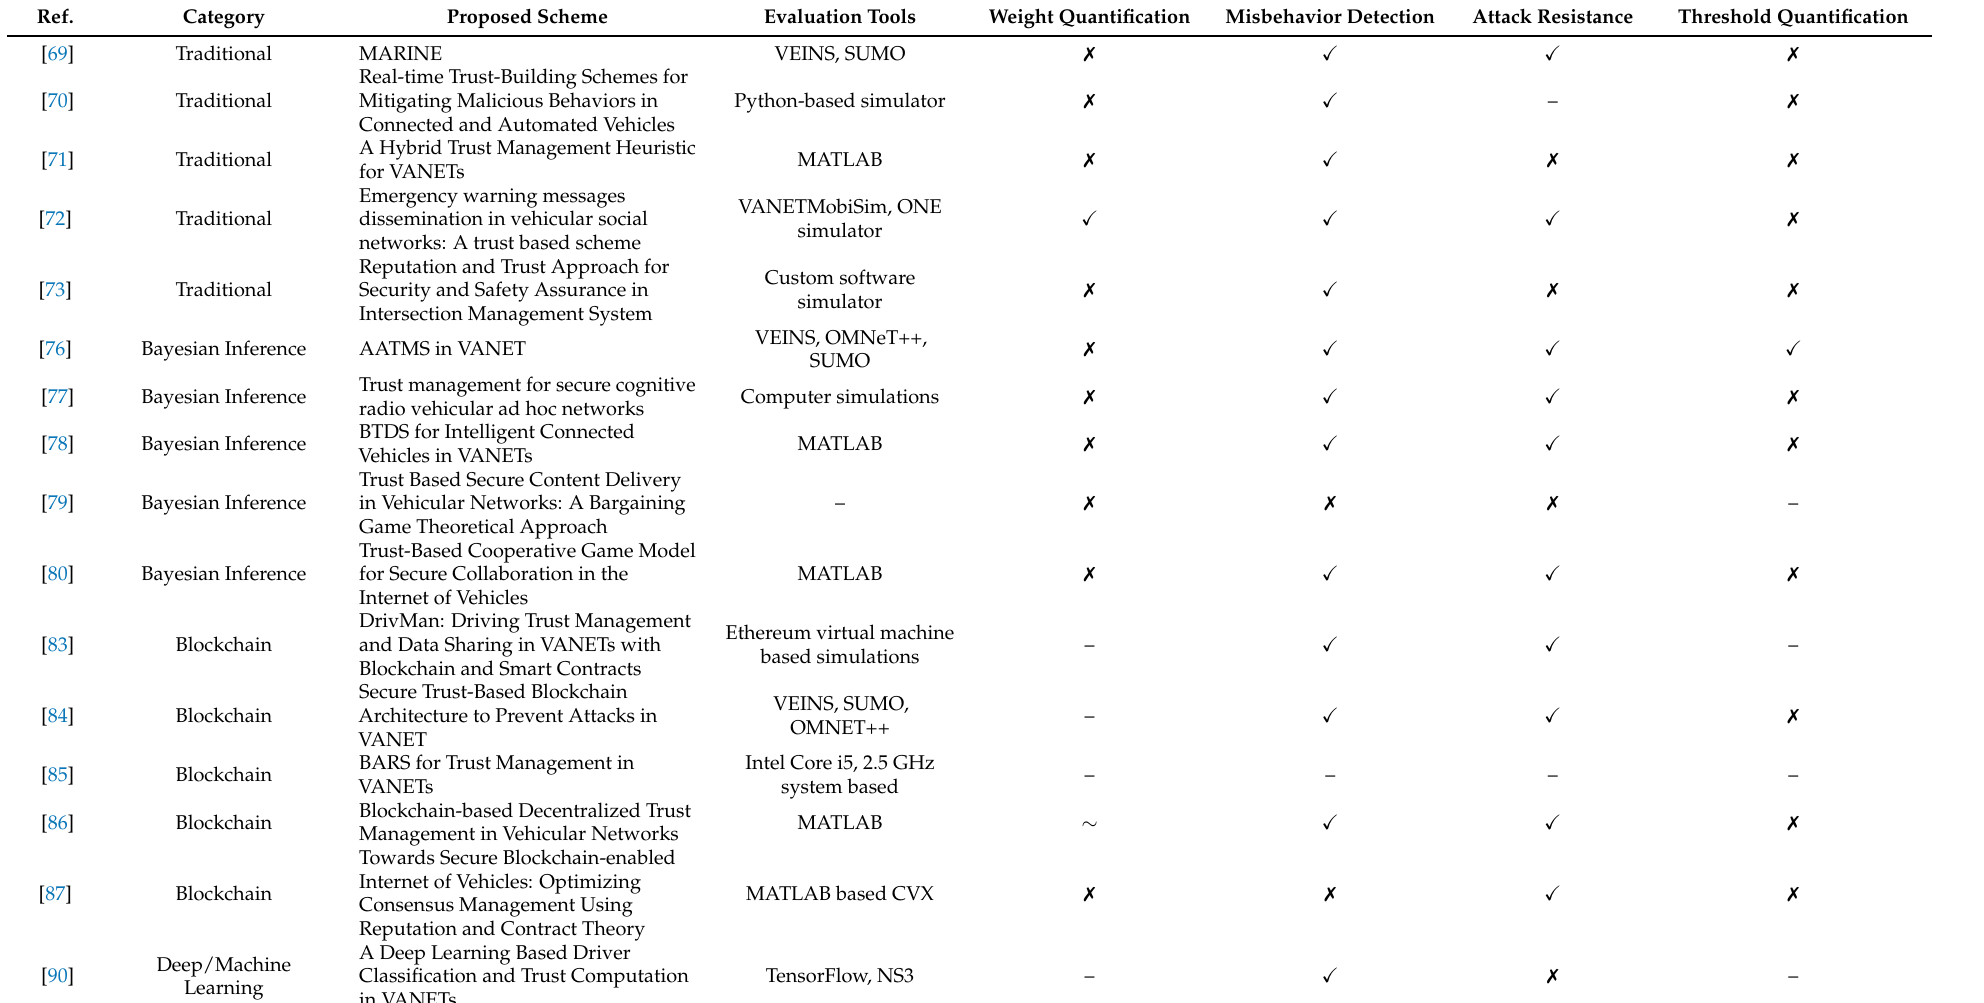
Table 2. Existing State-of-the-Art viz. Trust Management in Vehicular Networks.